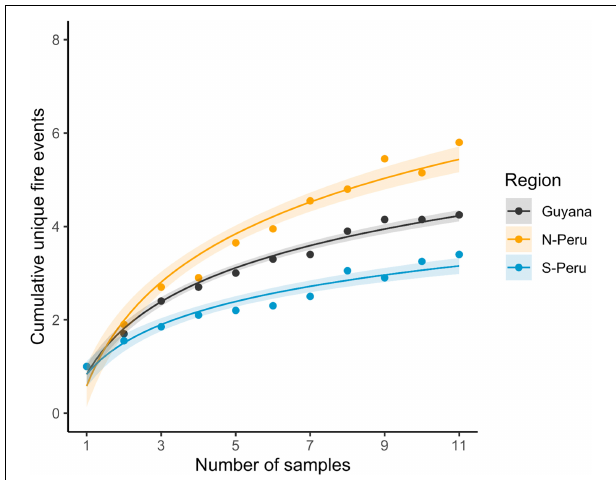
FIGURE 3 | Cumulative number of minimum unique fire events and the number of samples (sampling effort) based on a bootstrap resampling approach from samples from the three pits for each site. The curve represents log-transformed fits and shading represents 95% confidence